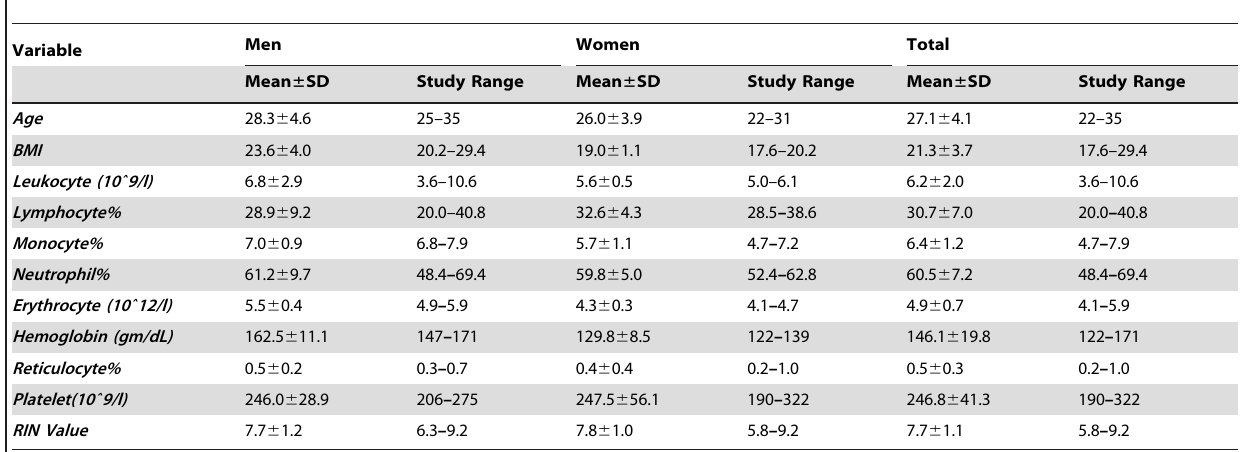
Table 1. Sample information on the basis of demography, blood cell counts and RNA